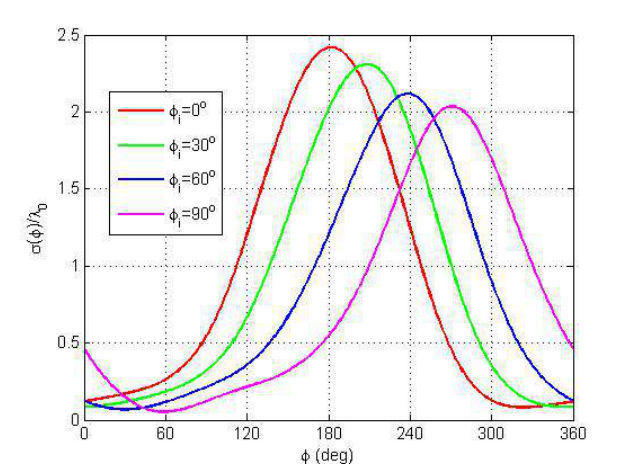
Figure 4: Normalized bistatic width against the scattering angle, when a gyroelectric elliptic cylinder with an axial ratio 2, 𝑘 with 𝜀 and 𝜇 is ! 𝑎 = 0.4𝜋 , !! = 4 , 𝜀 !! = −𝑗2 , !! = 2, excited by a plane wave of TE polarization, for 4 different angles of incidence.